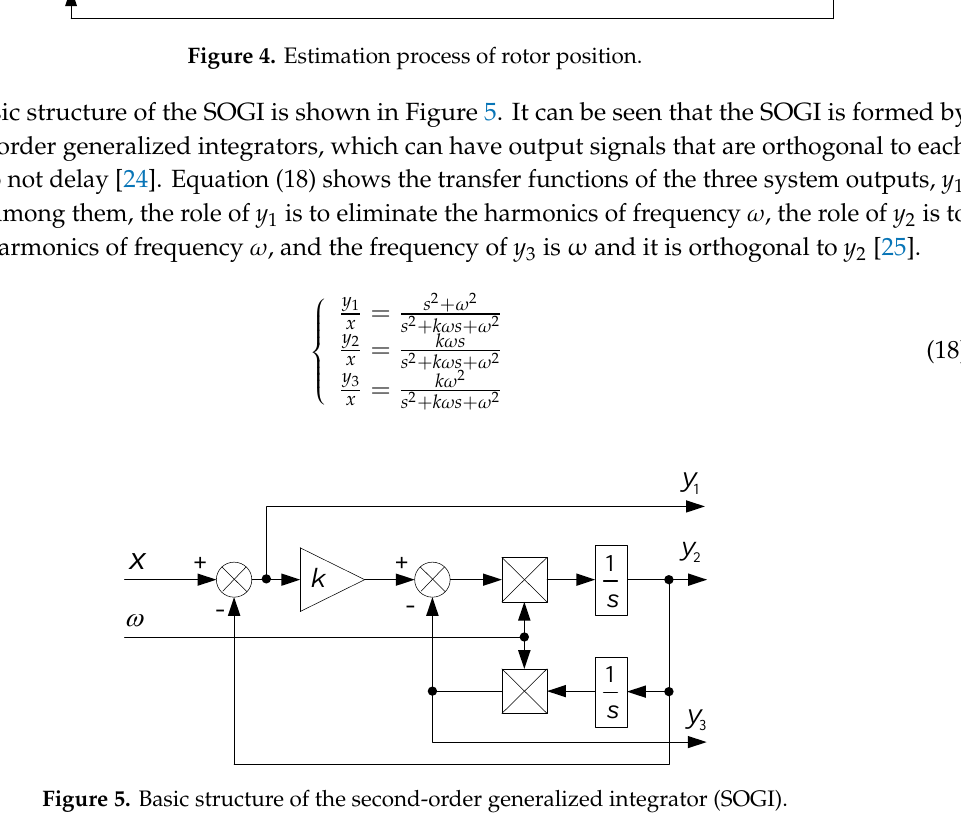
Figure 5. Basic structure of the second-order generalized integrator (SOGI).